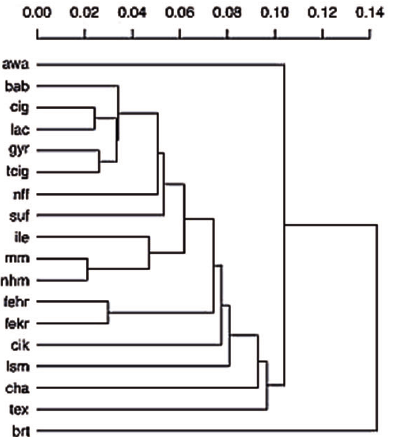
Figure 1. UPGMA dendrogram of Hungarian sheep breeds using the pairwise Fst distances as dissimilarity matrix. The scale repre- sents Fst distance.